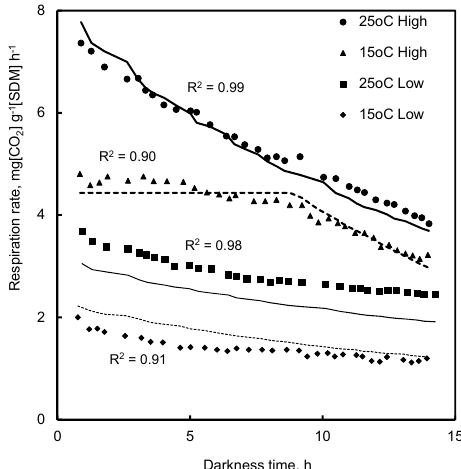
Figure 3. Respiration rate of bean plants in prolonged darkness after pre-treatment under high or low light [11]. Filled symbols are values after pretreatment under high light at 25 and 15 °C, and under low light at 25 at 15 °C, from top to bottom, respectively. Lines are predictions of the dynamic model. The R 2 is given for each time series.